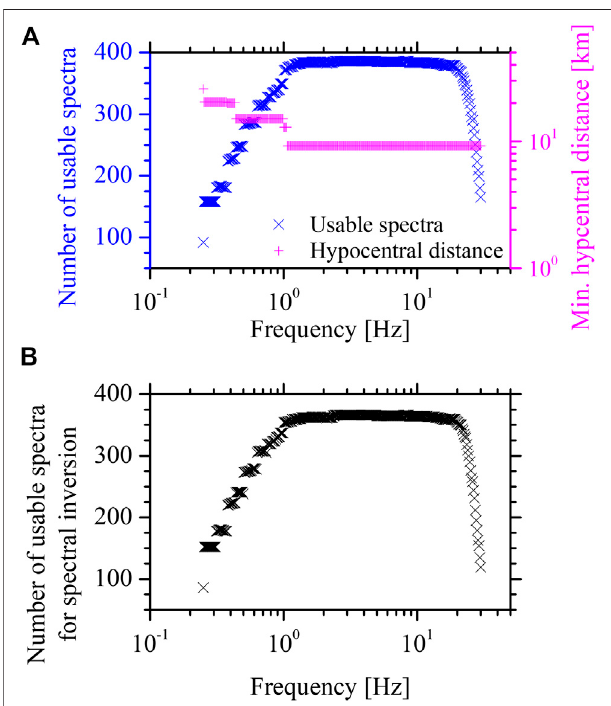
FIGURE3|(A) Thenumberofusablespectraandminimumhypocentral distance of usable spectra varied with the frequency. (B) The number of usable spectra at each frequency for the recordings selected for the spectral inversion